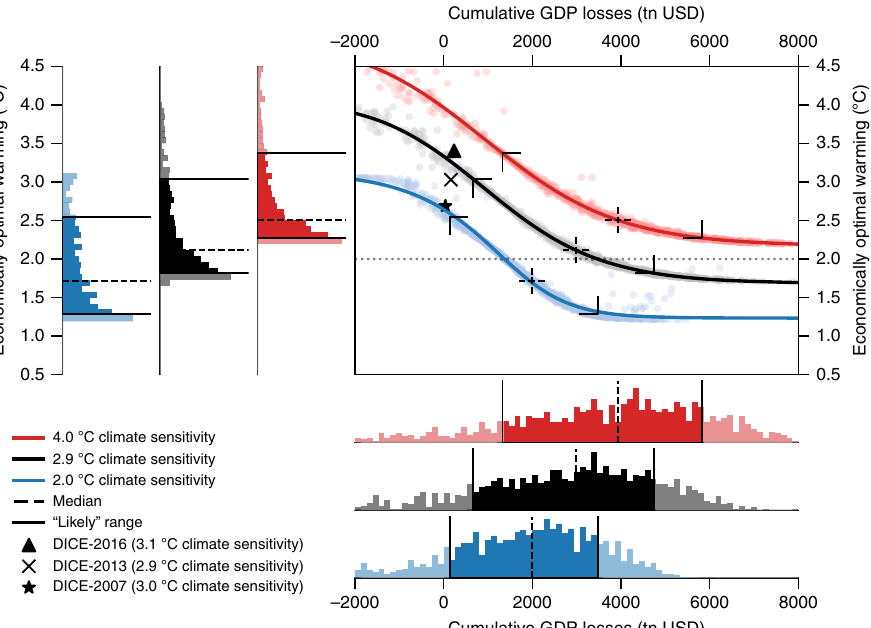
Fig. 3 Relation between the cumulative GDP losses until 2100 (in 2005 $US) in the absence of climate policy and the economically optimal warming until the end of the century, given uncertainty in the estimates of the historical impact and uncertainty in the climate sensitivity value. Scattered points give the uncertainty ensemble in the historical relation between temperature increase and economic growth for three different climate sensitivities; red points for 4 °C climate sensitivity, black points for the original climate sensitivity calibration in the DICE-2013R model, and blue points for 2 °C climate sensitivity. Each point depicts the DICE-2013 model output for a damage function calibrated according to one of the 1000 bootstraps of the historical regression. Curves in the main plot represent the best fi t for the relation between cumulative damage costs and optimal warming. The histograms below and on the left give the frequency of the model results as well as the medians and likely ranges for each of the three climate sensitivities. The likely rage of optimal end-of-century warming is approximately located between 2.3 °C and 3.4 °C with a median of 2.5 °C for the climate sensitivity of 4 °C, between 1.8 °C and 3 °C with a median of 2.1 °C for a climate sensitivity of 2.9 °C and between 1.3 °C and 2.5 °C with a median of 1.7 °C for a climate sensitivity of 2 °C. The results of the original DICE versions are located outside the likely ranges as shown by the black brackets.